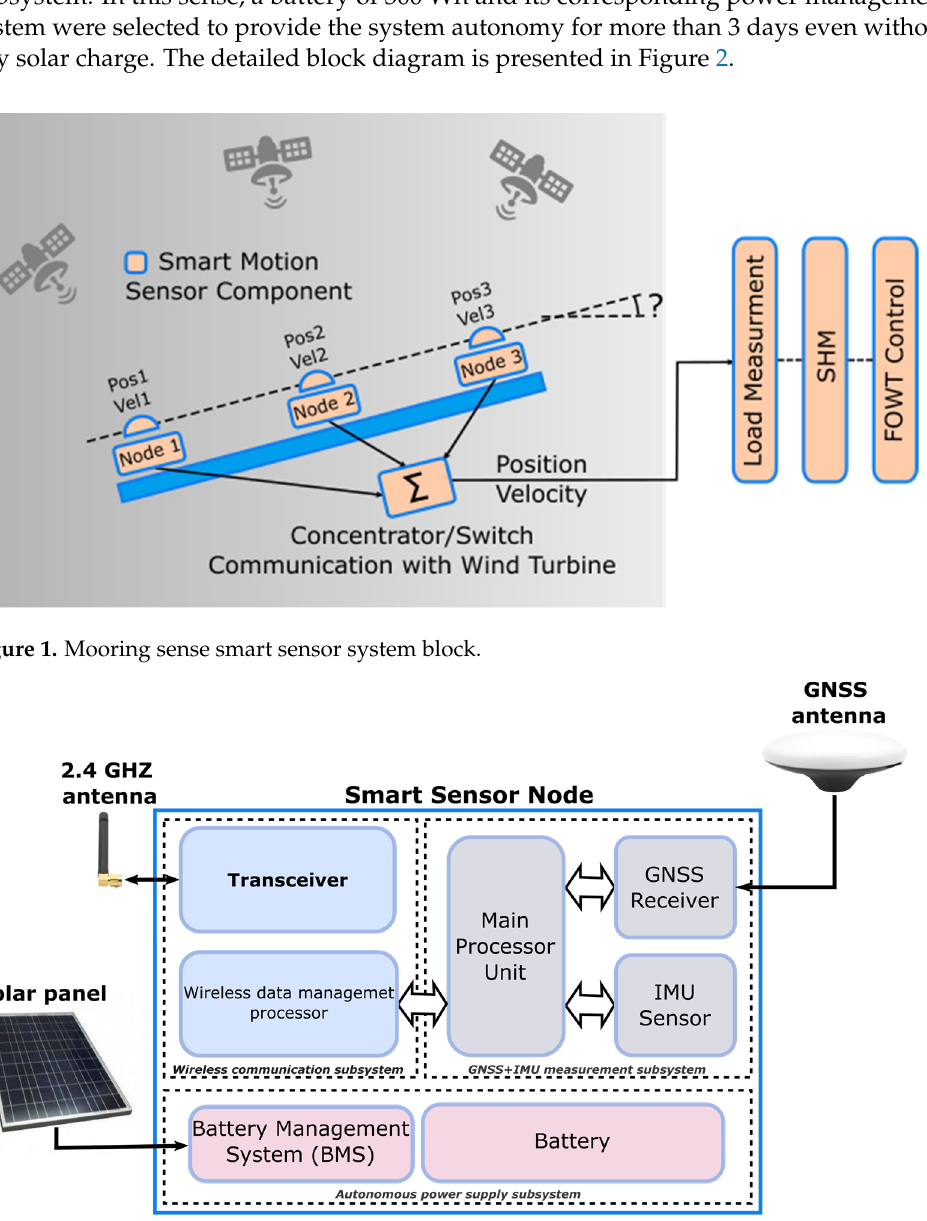
Figure 3. Smart sensor ( a ) waterproof housing and ( b ) internal view.